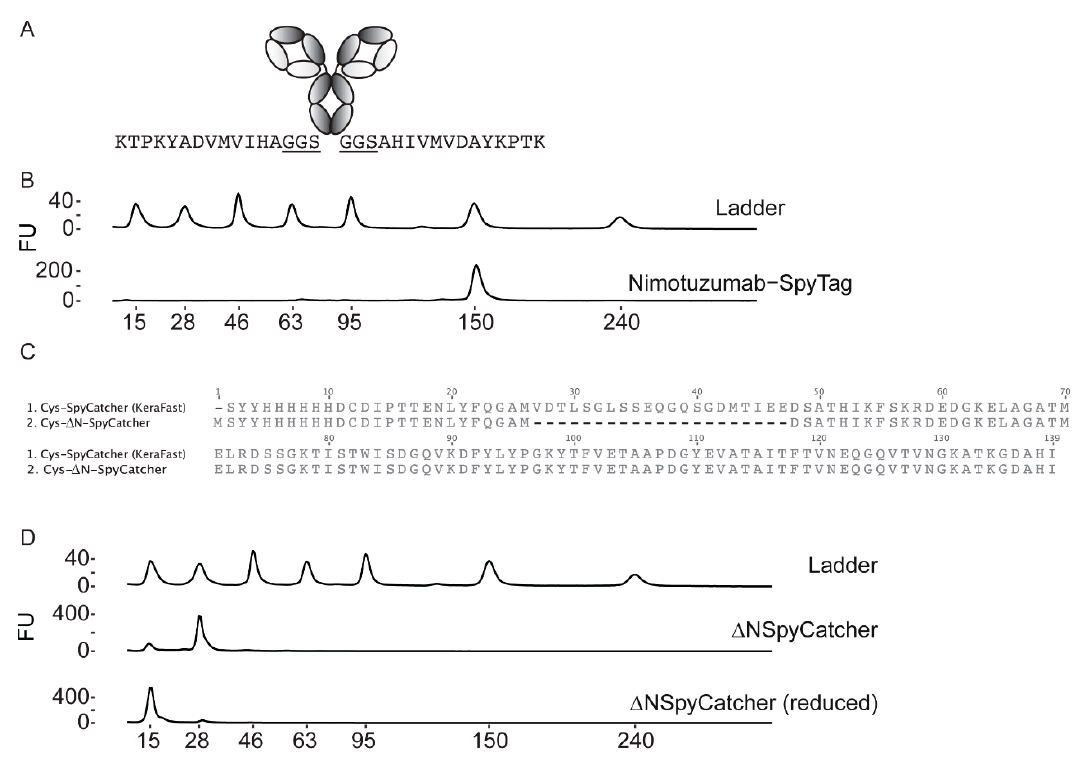
Figure 1. Starting biomolecules: ( A ) IgG-SpyTag. IgG is made up of two light (VL+CL) and heavy (VH+CH1+CH2+CH3) chains. The IgG is expressed with the SpyTag sequence at the C-terminus. ( B ) Bioanalyzer chromatogram of ladder and purified nimotuzumab-SpyTag (150 kDa) protein. ( C ) Sequence alignment of Cys-SpyCatcher and the Cys- Δ N-SpyCatcher construct used in this manuscript. ( D ) Bioanalyzer chromatogram of ladder and purified Cys- Δ N-SpyCatcher under non- reducing (monomer: 14.8 kDa; dimmer: 27.6 kDa) and reducing (15.2 kDa) conditions.